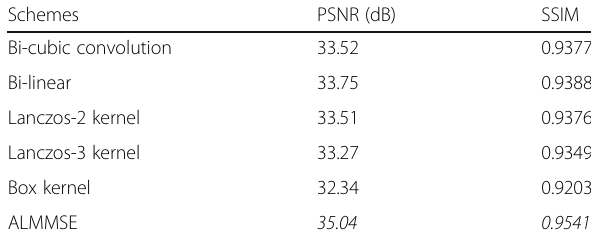
Table 2 Results for video